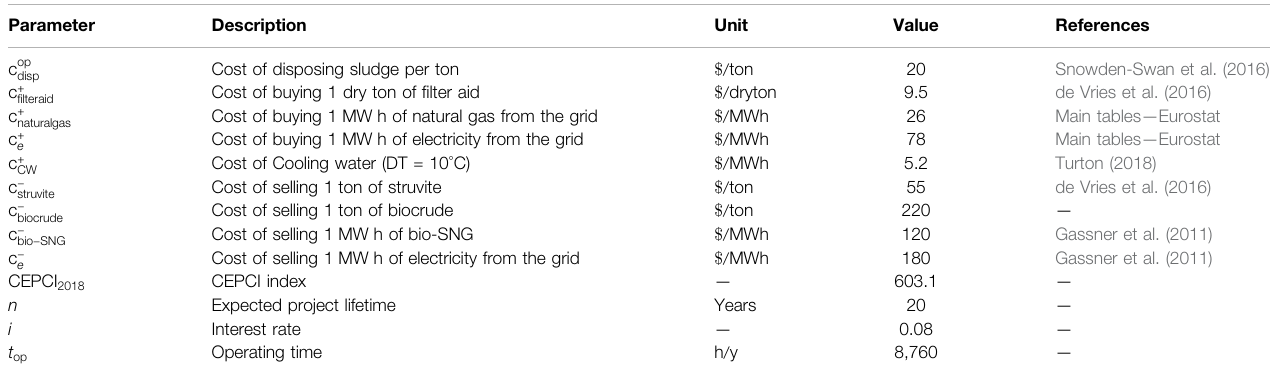
TABLE 3 | Utilities operating costs and general economic assumptions.